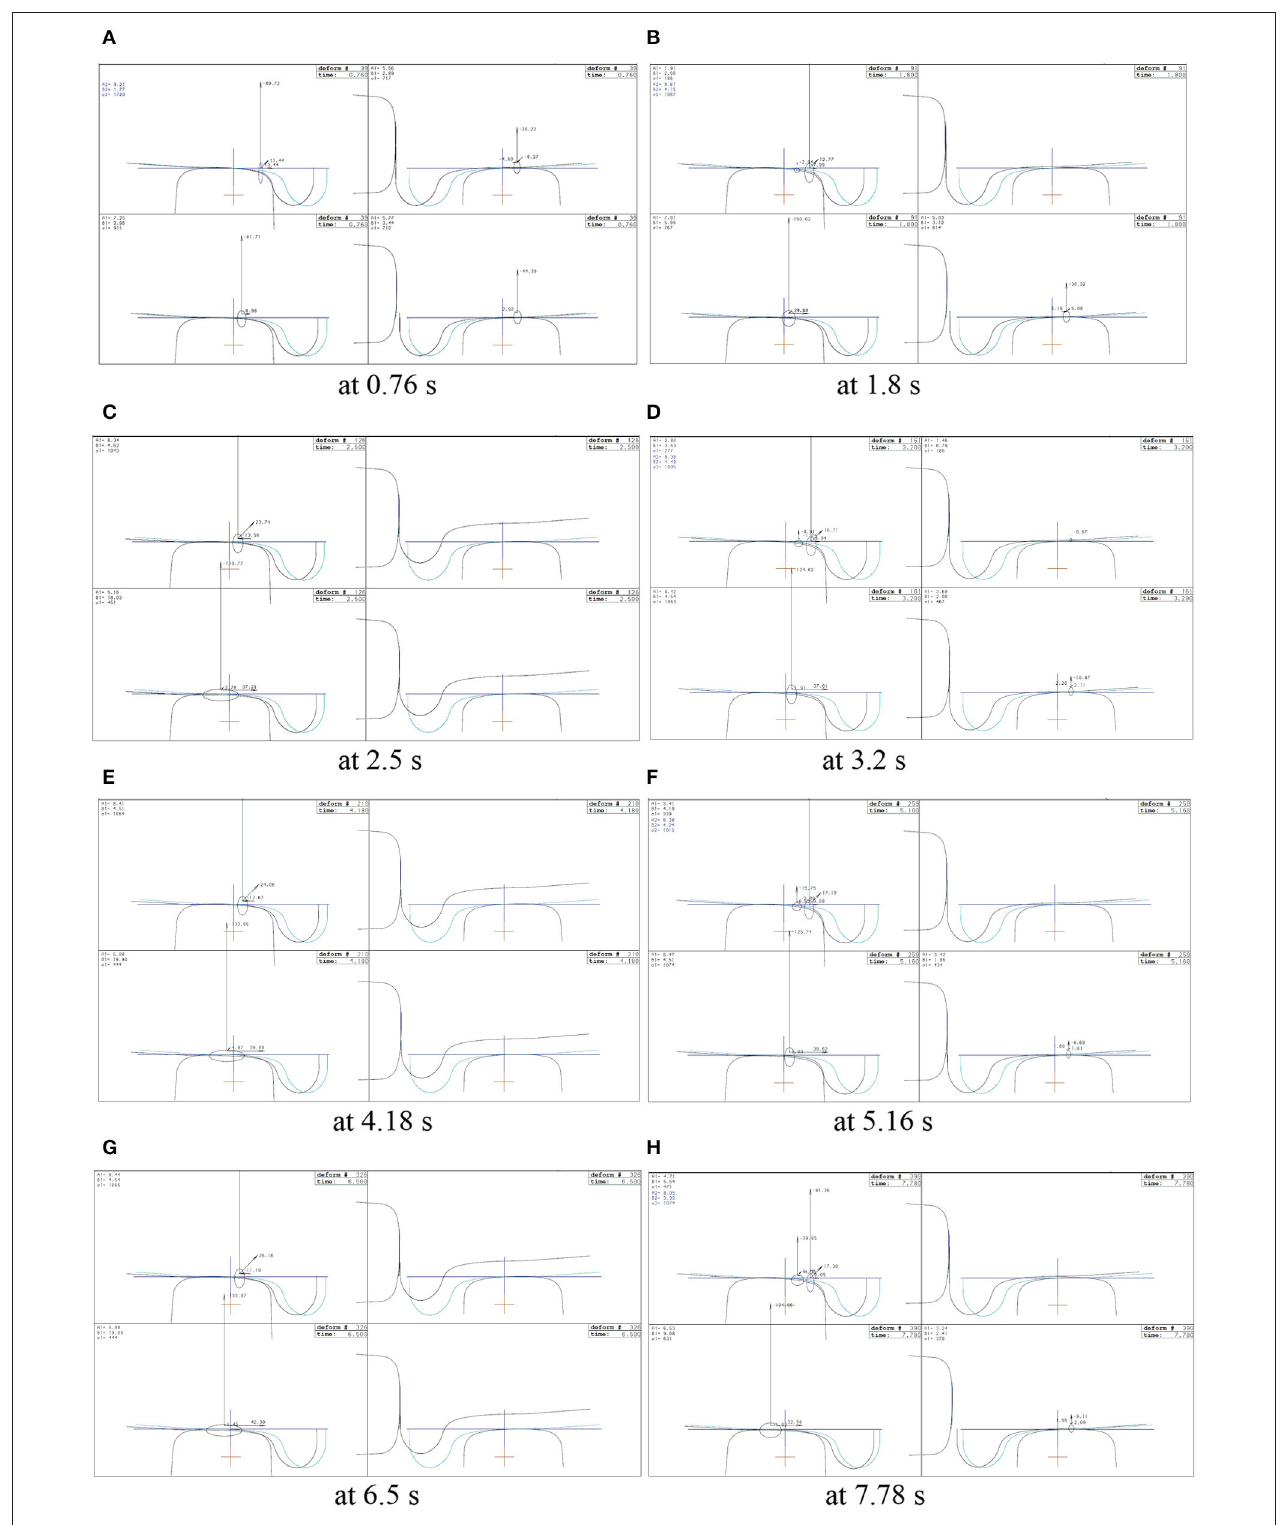
FIGURE 10 | Simulation at speed of 119km/h with guard